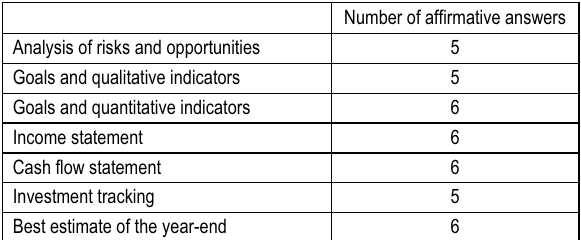
Table 14 (cont.). Answer to the question: